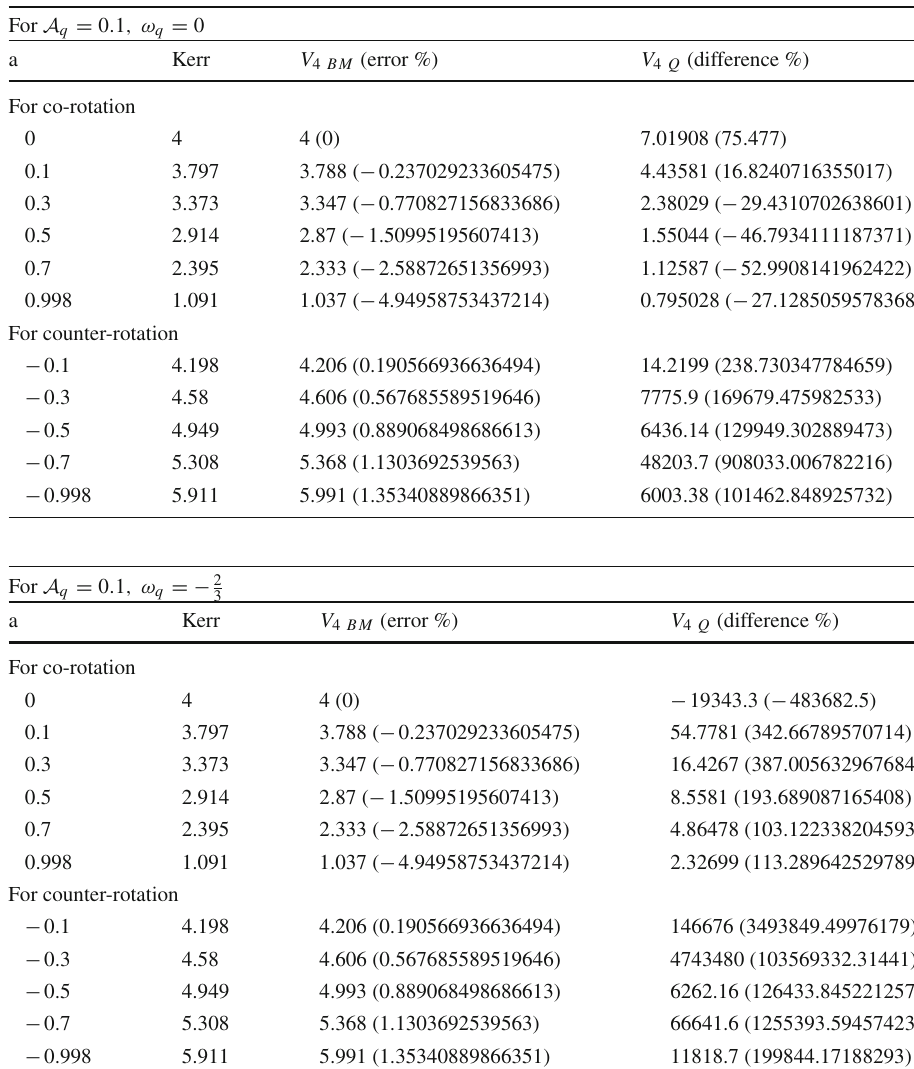
PNPs for relatively high DE effect in pressure-less dust